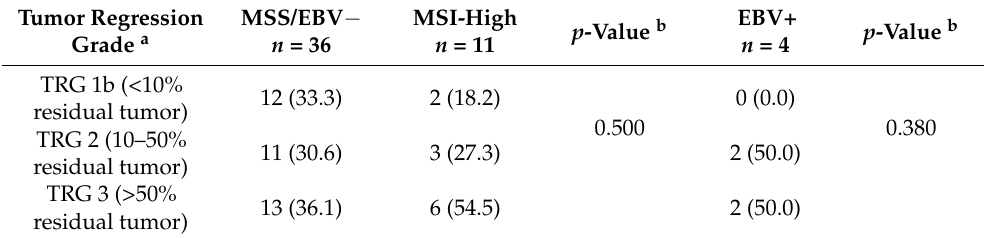
Table 2. Tumor regression status after neoadjuvant